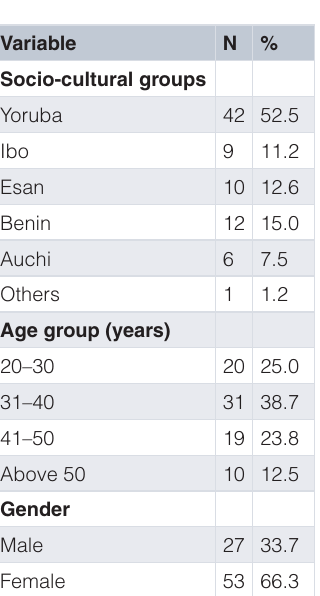
Table 1. Demographic profile of combined sample (n = 80).